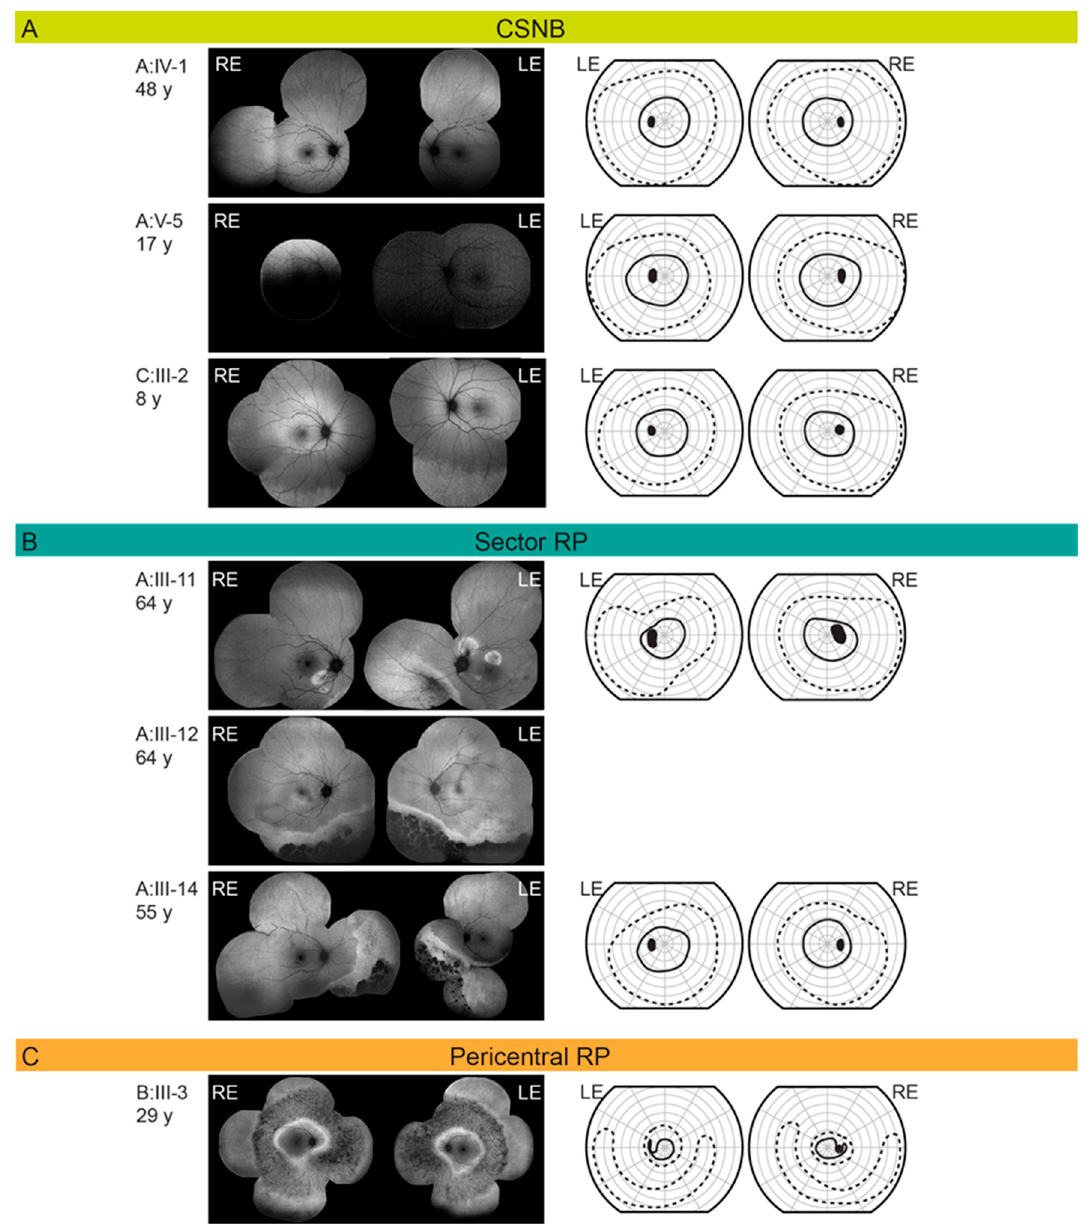
Figure 4. ( A ) Fundus autofluorescence and Goldmann visual field in RHO p.G90D patients diagnosed with congenital stationary night blindness (CSNB). ( B ) Fundus autofluorescence and Goldmann visual field in RHO p.G90D patients diagnosed with sector retinitis pigmentosa (RP). ( C ) Fundus autofluorescence and Goldmann visual field in RHO p.G90D patients diagnosed with pericentral retinitis pigmentosa (RP). Patient ID and age are stated on the left of each row. The full and dashed lines represent the II/1 (dim target) and II/4 (bright target) isopters, respectively. Abbreviations: CSNB— congenital stationary night blindness; RP—retinitis pigmentosa; RE—right eye; LE—left eye .